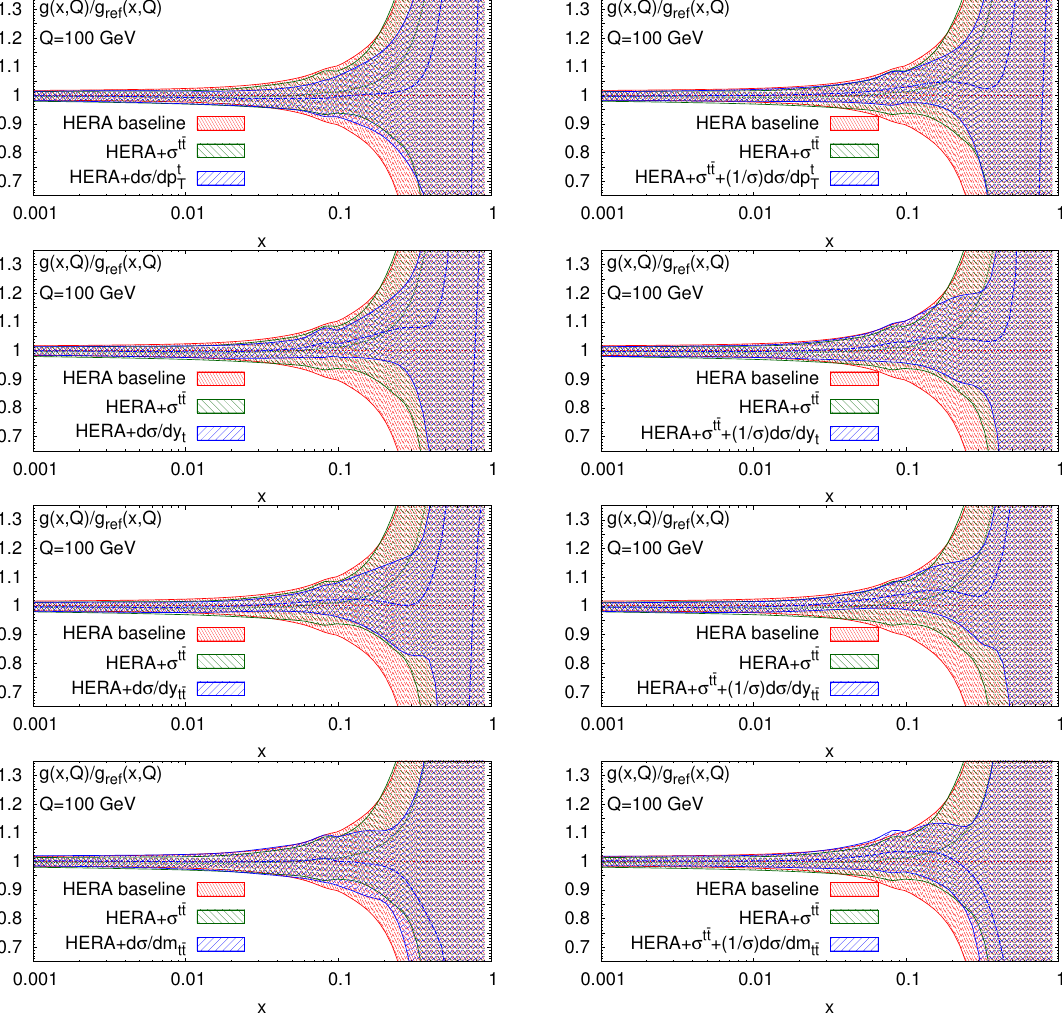
Figure 14 . The gluon PDF from the HERA-only (cid:12)ts corresponding to the same input combinations of LHC top-quark data, both at the level of absolute (left) and of normalized distributions (right). normalized to the central value of the HERA-only baseline. For completeness, we also